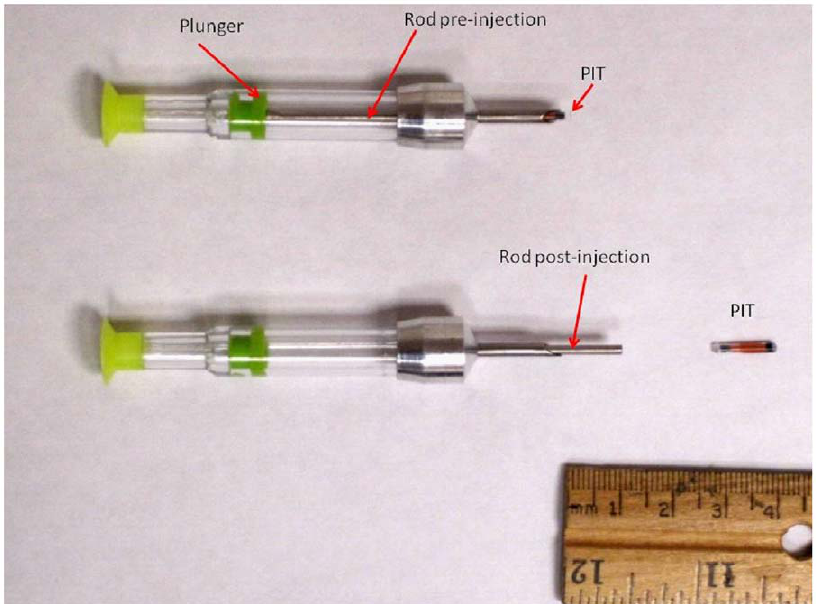
Figure 1. Prototype darts were used to assess remote delivery of Passive Integrated Transponder tags (PIT) into a gelatin block. Prototype darts included a steel rod used to expel the PIT with the aid of a rubber plunger. Darts with and without powder charges behind the rubber plunger were used to determine the influence of injection speed on penetration depth of PIT into tissue.